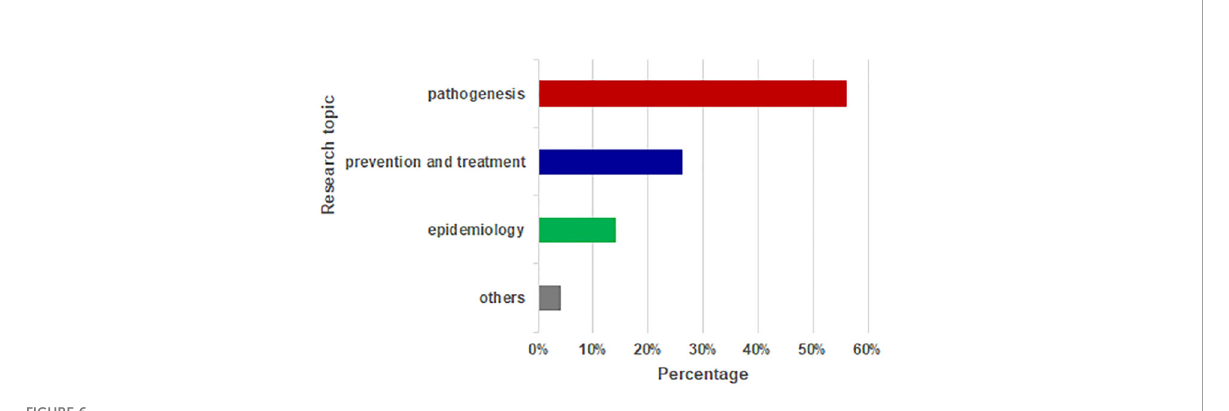
FIGURE 6 Research topic of published research